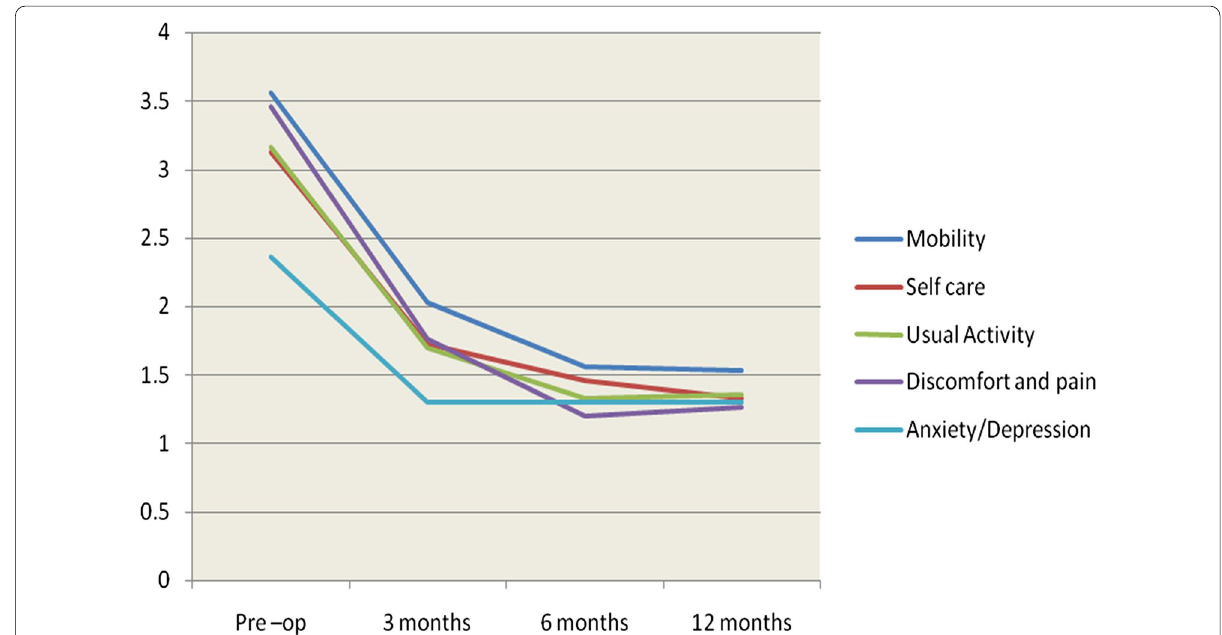
Fig. 1 Line diagram depicting the improvement in all the components of HRQoL (health-related quality of life) from preoperative period to postoperative 12-month follow-up